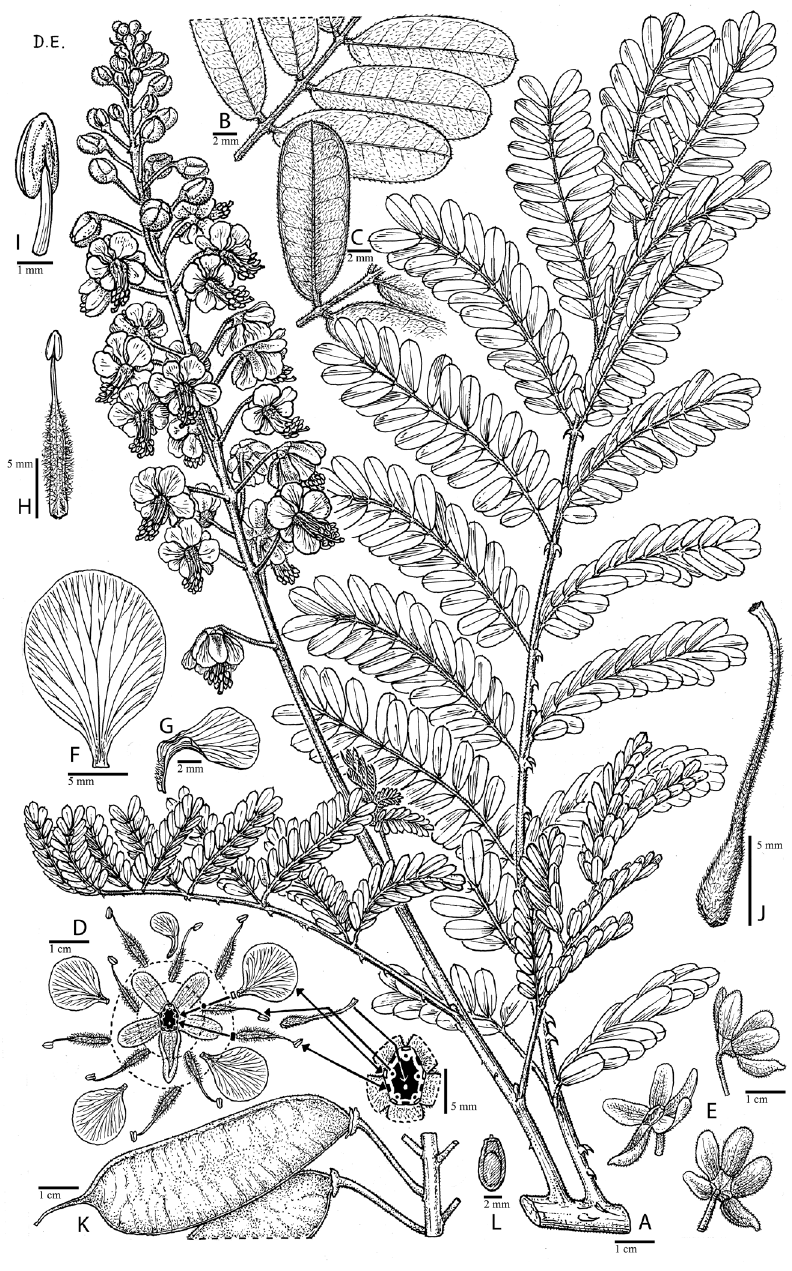
Figure 22. Biancaea decapetala (Roth) O. Deg. A flowering branchlet and foliage B, C leaflets viewed from above and below, respectively D flower with parts separated, and centre of flower enlarged E calyx three views F lateral petal G median petal H stamen I anther J gynoecium K fruits L seed. A from Ruth- erford-Smith 11062 B, C from White 2478 D–J from Chase 4564 K , L from Myre 2528. Drawn by D. Erasmus, originally published in Flora Zambesiaca , vol. 3 part 2, page 182, figure 3.2.39